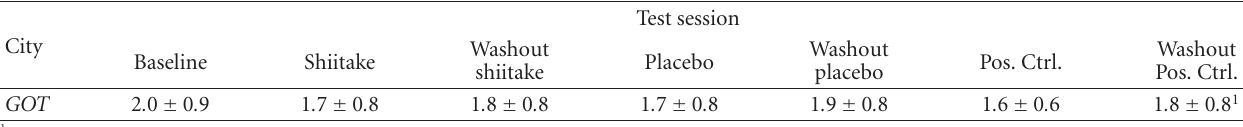
Table 2: Quigley-Hein plaque index score (Turesky modification 1970) (mean ± SD) after baseline, the three legs of the crossover (shiitake, placebo, positive control (AmF-SnF 2 ; Pos Ctrl)) and three washout periods (washout shiitake, washout plaque, and washout positive control) for GOT ( n = 30). Mean ± SD.